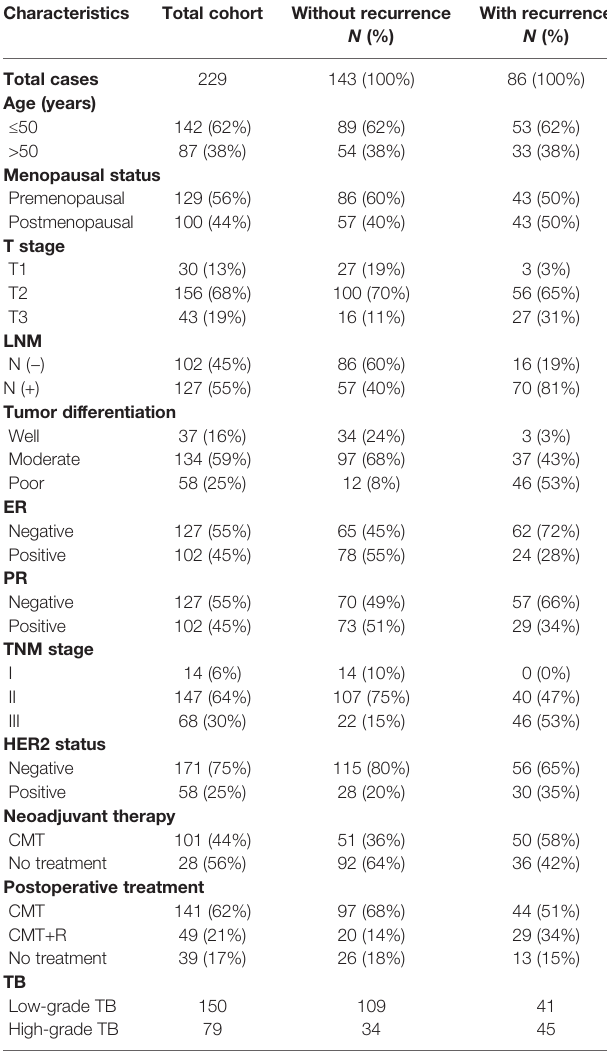
TABLE 1 | Basal characteristics of 229 patients with invasive